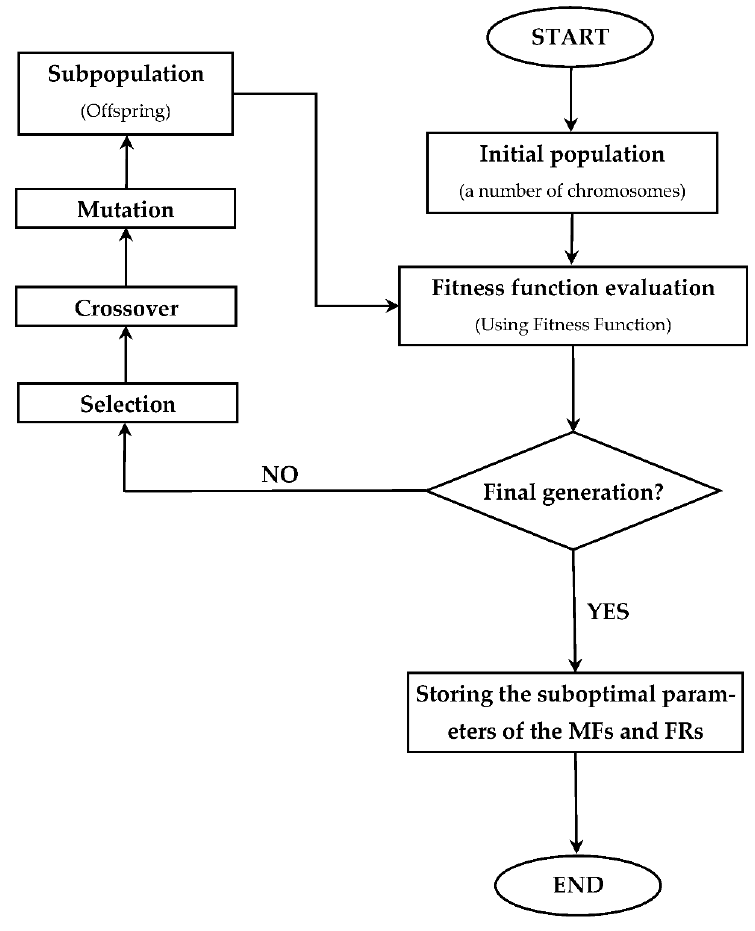
Figure 12. The flow chart of the genetic algorithm process.